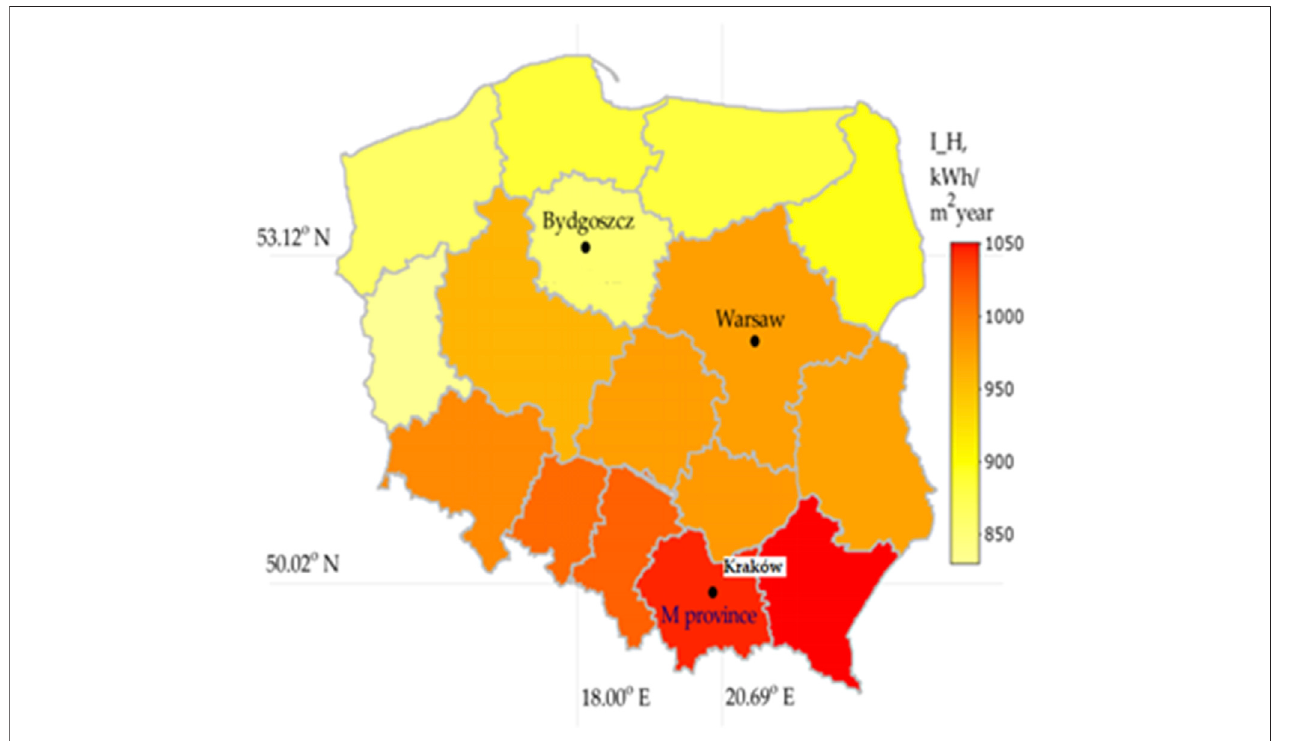
FIGURE 2 | Map of average insolation values (Olczak et al.,